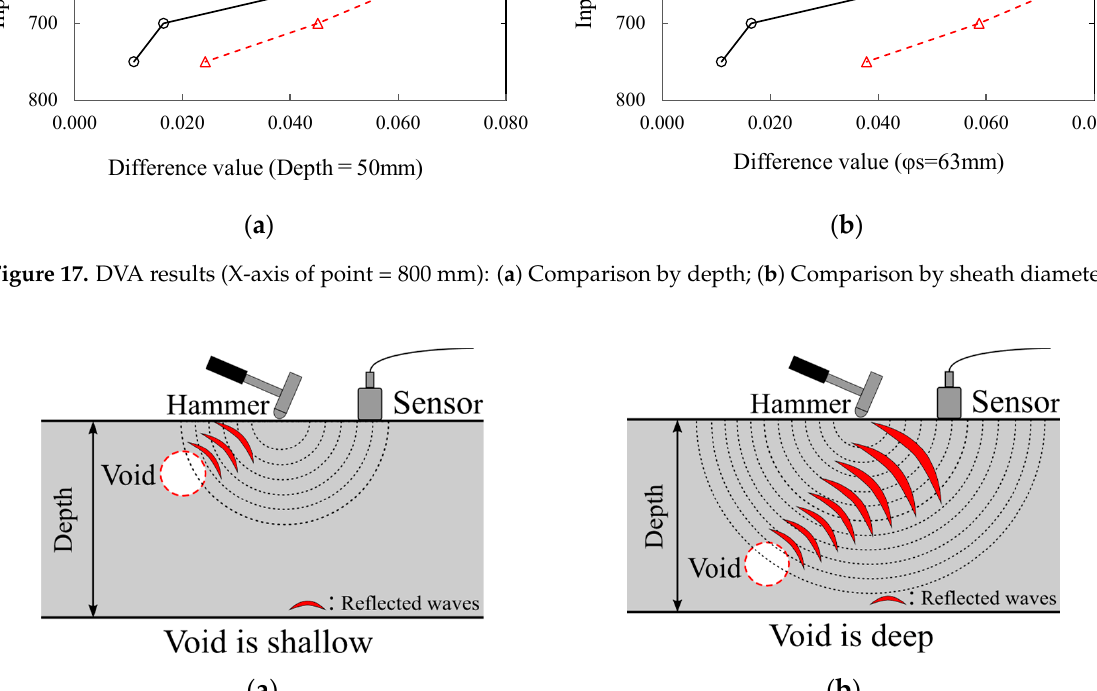
Figure 18. Schematic illustration of the propagation of the reflected waves due to change in void depth: ( a ) Shallow void; ( b ) Deep void.